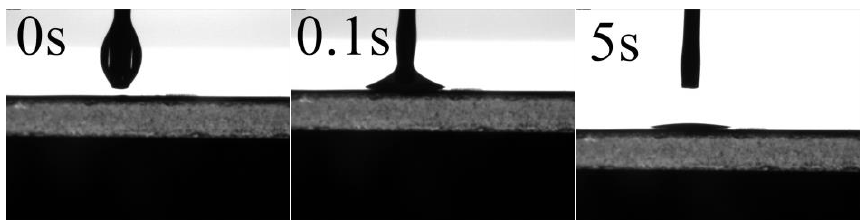
Figure 6. Variation of oil (diesel) contact angle depended on time for upper surface of M3. Table 3. Filtration rate and separation efficiency for surfactant-free water-in-oil emulsion of PVDF-HFP porous